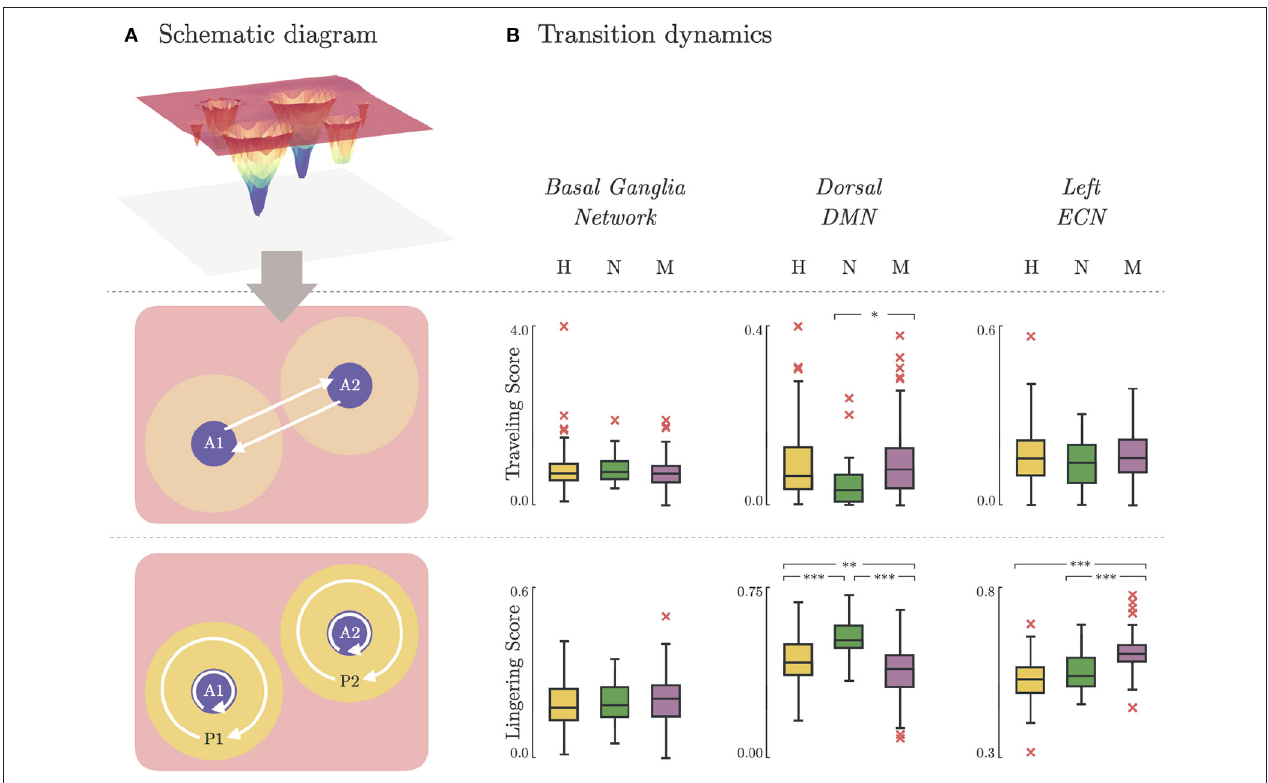
FIGURE 5 | Brain state transition dynamics. (A) Schematic diagram illustrating the transition dynamics for traveling score (basin-to-basin; Equation 10) and lingering score (within-basin or within-peripheral; Equation 11). (B) Traveling and lingering scores for Healthy, Non-melancholic, and Melancholic groups on BGN, DDMN, and LECN. (*) p < 0.05, (**) p < 0.01, and (***) p < 0.005; between-group, pairwise comparison of traveling/lingering scores using one-way ANOVA with Bonferroni